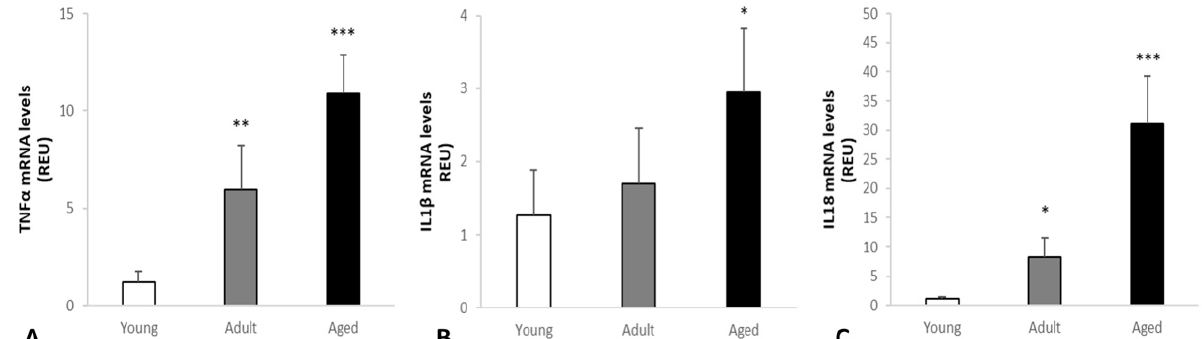
Figure 6. Changes of TNF- α , IL-1 β and IL-18 levels in the skeletal muscle of cows measured with RT-PCR analysis. Our results showed that TNF- α , IL-1 β and IL-18 were differently expressed in the three groups. ( A ) TNF- α levels were very low in young cows (Group C) and increasingly higher in adult to aged animals (** p < 0.01; *** p < 0.001 vs. control). ( B ) IL-1 β levels were increasingly higher from young cows (Group C) to adult and aged animals (Group B and A, respectively) (* p < 0.05 vs. control). ( C ) IL-18 levels were very low in young cows (Group C) and increasingly higher in adult to aged animals (Group B and A, respectively) (* p < 0.05; *** p < 0.001 vs. control).